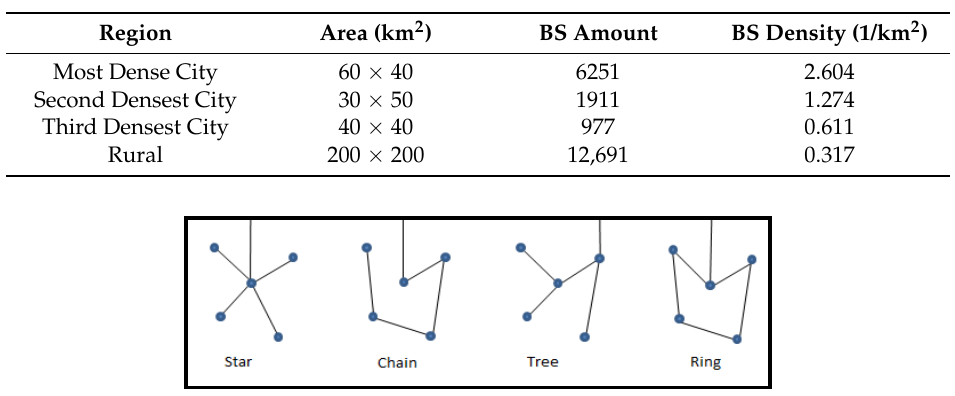
Figure 2. Typical cellular microwave-link (CML) topologies. All four are such that the number of CMLs is approximately identical to the number of BS [6].